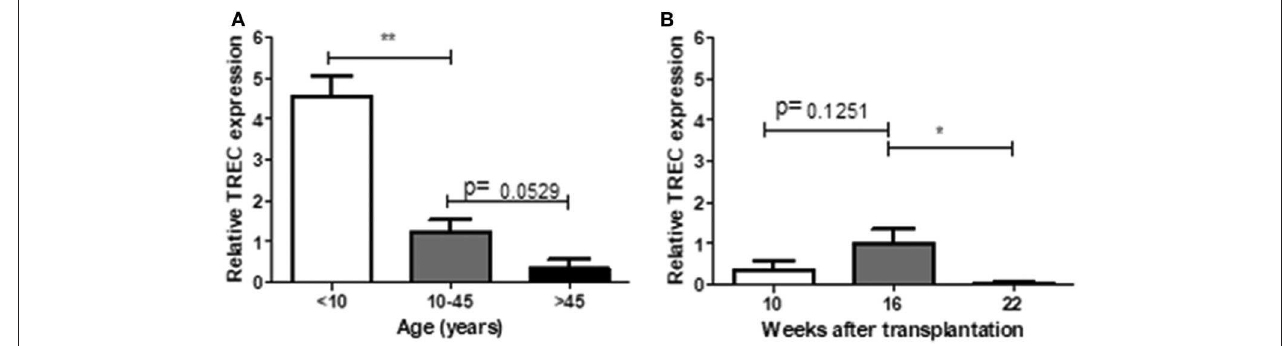
FIGURE 6 | Relative TREC expression between human and humanized mice. PBMCs prepared from 14 healthy individuals (A) and hu-mice at 10 th , 16 th , and 22 nd week (B) were analyzed for the relative TREC expression by real-time PCR. Relative expression levels (normalized to TRAC) shown as the mean ± SEM ( n = 3–7 human samples were analyzed at each age range, n = 3–4 animals were analyzed at each time point). Data are presented as mean ± SEM. * p < 0.05 and ** p <